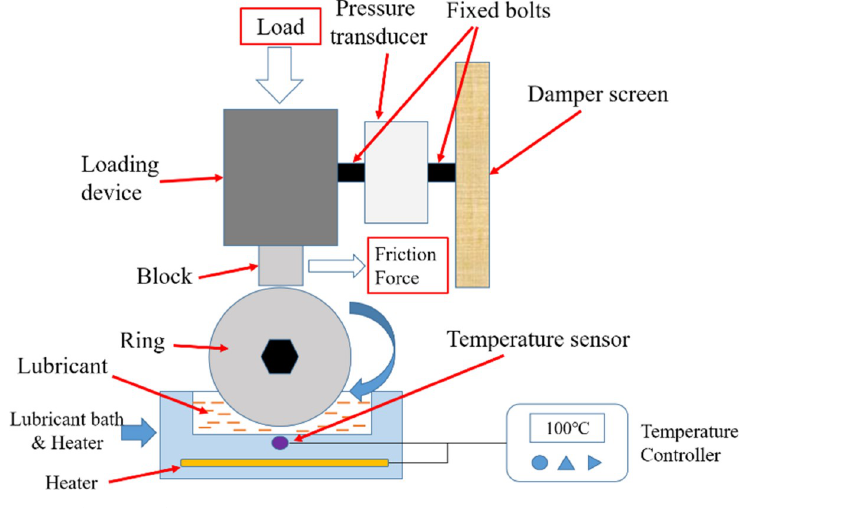
Fig 3. Schematic of test